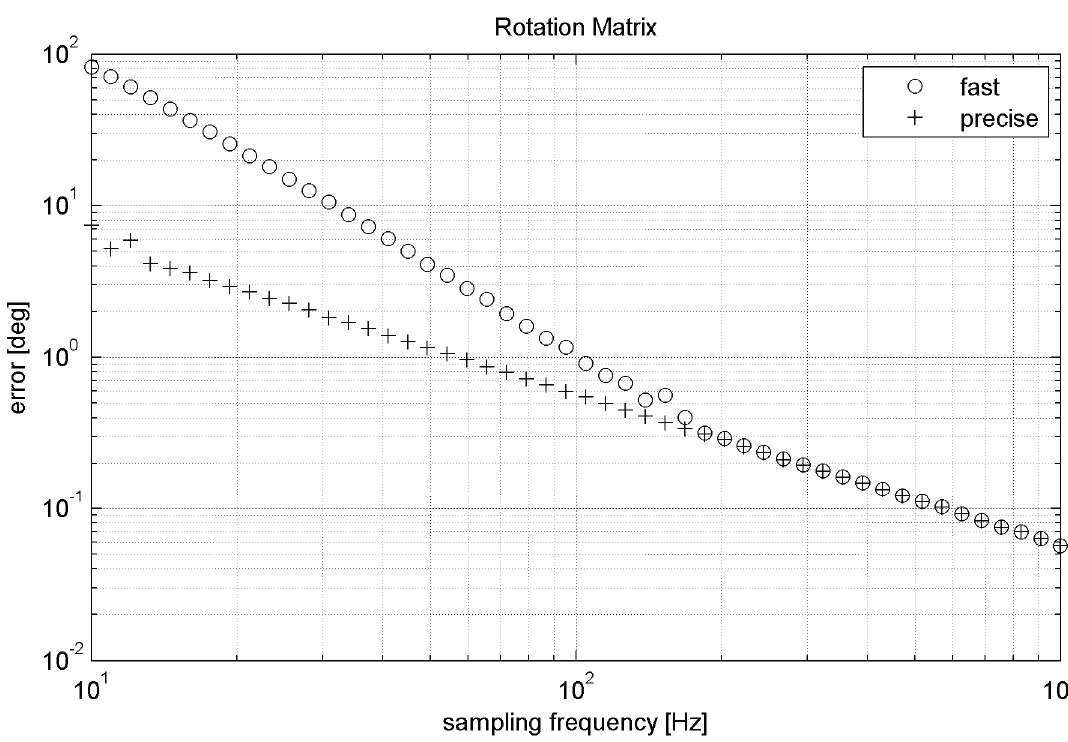
Figure 7. Errors of the matrix-based algorithms during simulated